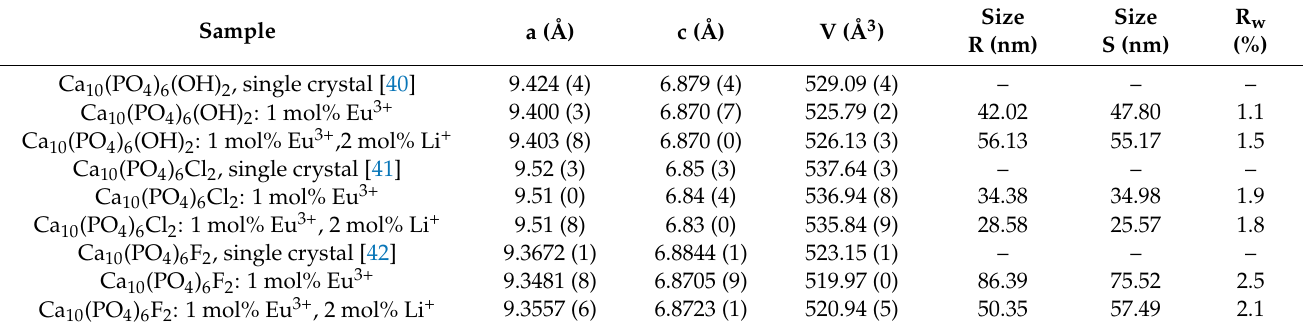
Table 2. Unit cell parameters (a,c), cell volume (V), mean crystallites size calculated according to the Scherer (S) and Rietveld (R) method as well as refine factor (R W ) for the Ca 5 (PO 4 ) 3 Z (where Z—OH − , Cl − , F − ) doped and co-doped with 1 mol% Eu 3+ and 2 mol% Li + powder prepared at 500 ◦ C.